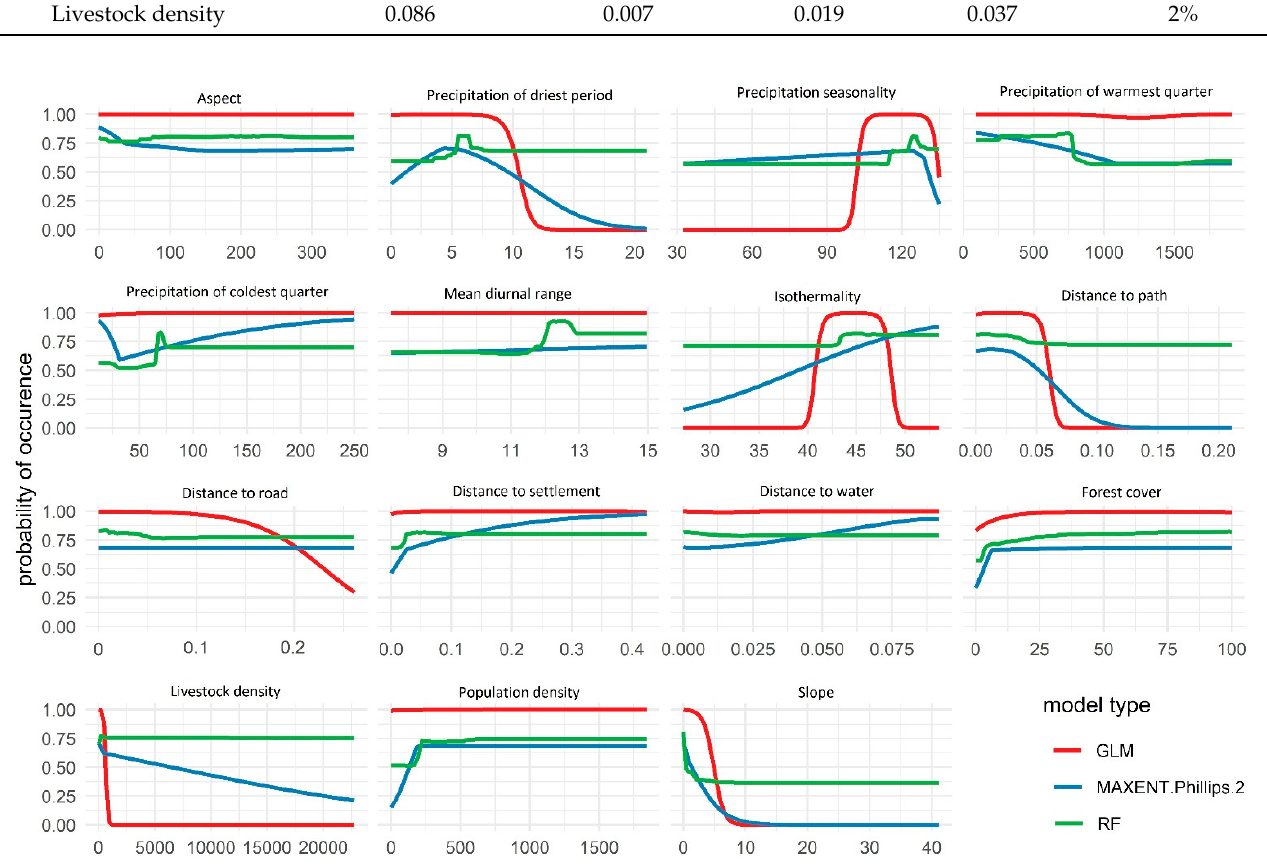
Figure 3. Response curves indicating the effects of different environmental variables on the habitat suitability of the Blue bull in Nepal.